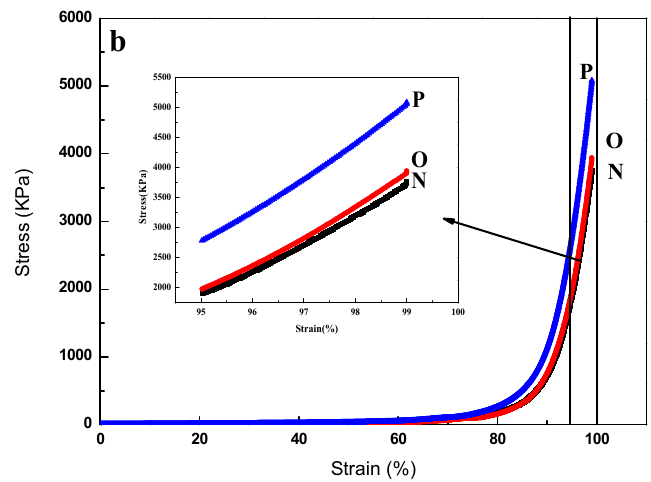
Figure 2. Strain–force curves of hydrogels: normal hydrogel (N), hydrogel containing ordinary microspheres (O), and hydrogel containing polymerizable microspheres (P). ( a ) Compression strain 90%; ( b ) compression strain 99%.